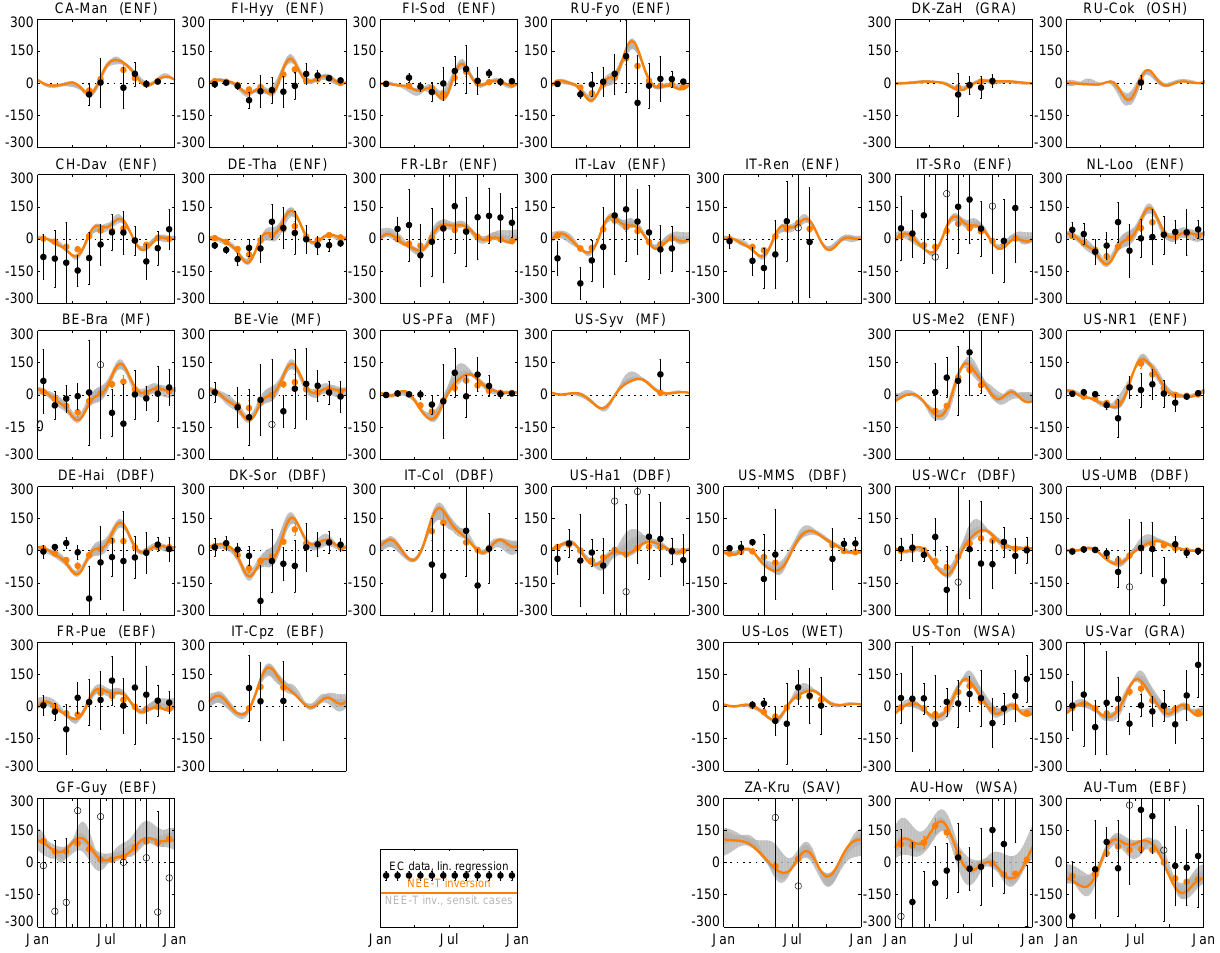
Figure 3. Comparison between the inter-annual climate sensitivities calculated from the inversion and from eddy covariance (EC) data for various sites with longer EC records. Black dots give the sensitivities g EC calculated by the linear regression of monthly EC CO 2 flux NEE- T data (FLUXNET2015 data set) against monthly air temperature co-measured at the flux towers (months with data in only 6 years or less are discarded). The error bars around the dots comprise the confidence intervals of the regression slopes (at the 90% confidence level); if the confidence interval is above 300(gCm − 2 yr − 1 )K − 1 (i.e. larger than the typical seasonal range), the corresponding dot is hollow. Orange and grey lines give the sensitivities γ NEE- T taken directly from various NEE– T inversions (base and sensitivity cases as in Fig. 2) at the respective pixels enclosing the EC site locations. To allow for a more direct comparison between NEE– T inversion results and EC data, sensitivities for the inversion (base case) have also been calculated by linear regression from the total monthly mean non-fossil CO 2 flux and the temperature field employed in the inversions in the same way and subsampled at the same months as for the EC data; these g Inv values are shown as NEE- T orange dots. Panels are roughly ordered by latitude and land cover type (DBF: deciduous broadleaf forest, EBF: evergreen broadleaf forest, ENF: evergreen needleleaf forest, GRA: grassland, MF: mixed forest, OSH: open shrubland, SAV: savanna, WET: permanent wetland, WSA: woody savanna). See Table 2 for EC site